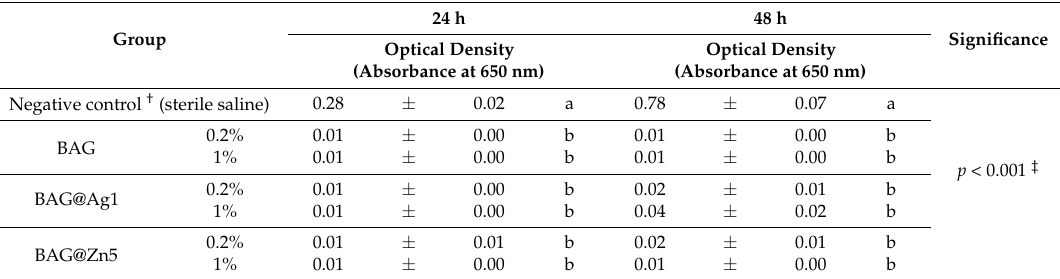
Table 2. Antibacterial properties difference between the BAG and ion (silver or zinc)-doped BAG orthodontic bonding primer.